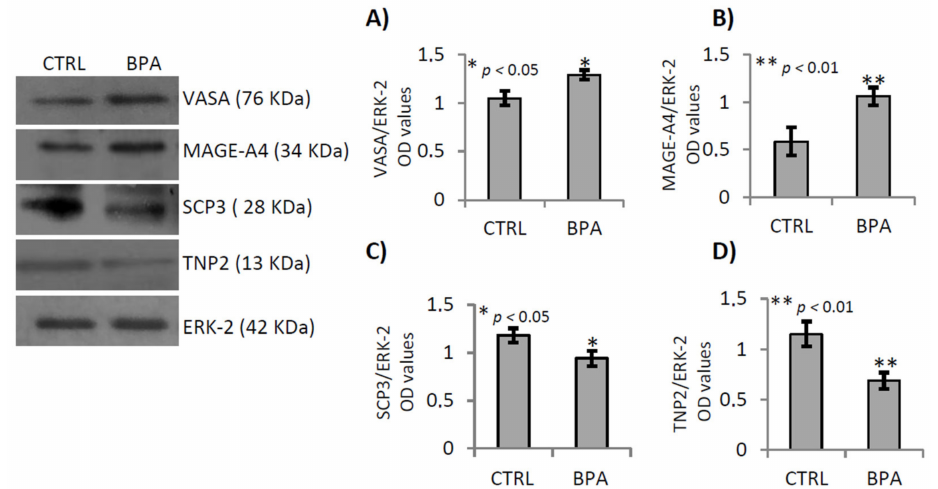
Figure 5. Gene expression analysis of germ cells markers in testis of male mice early-life exposed to vehicle (CTRL, n = 3/4) or BPA (BPA, n = 4) and sacrificed at 78 dpp . Western Blot analysis of VASA, MAGE-A4, SCP3 and TNP2. Protein amounts were quantified by densitometry analysis, normalized against ERK-2 signals, and expressed in OD values as fold change ( A – D ). All data were reported as mean value ± S.E.M. (*: p < 0.05; **: p <